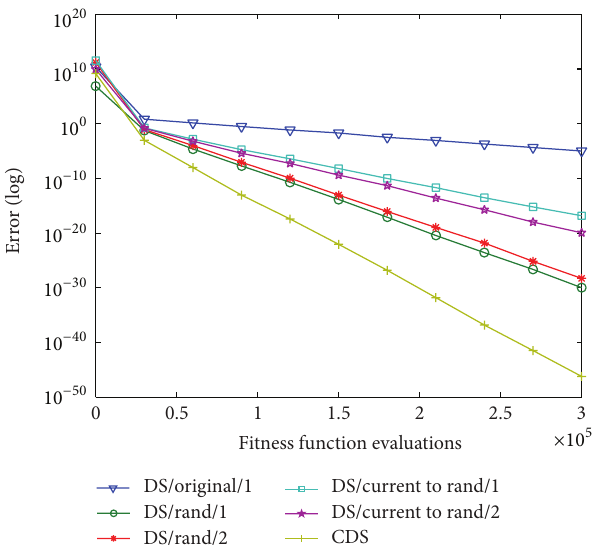
Figure 5: Comparison of performance of six algorithms for mini- mization of 𝑓 05 with dimension 30.